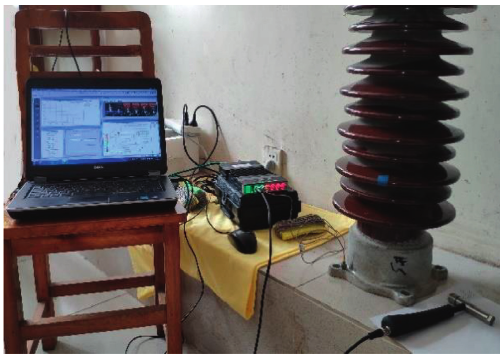
Figure 11: Hammering excitation